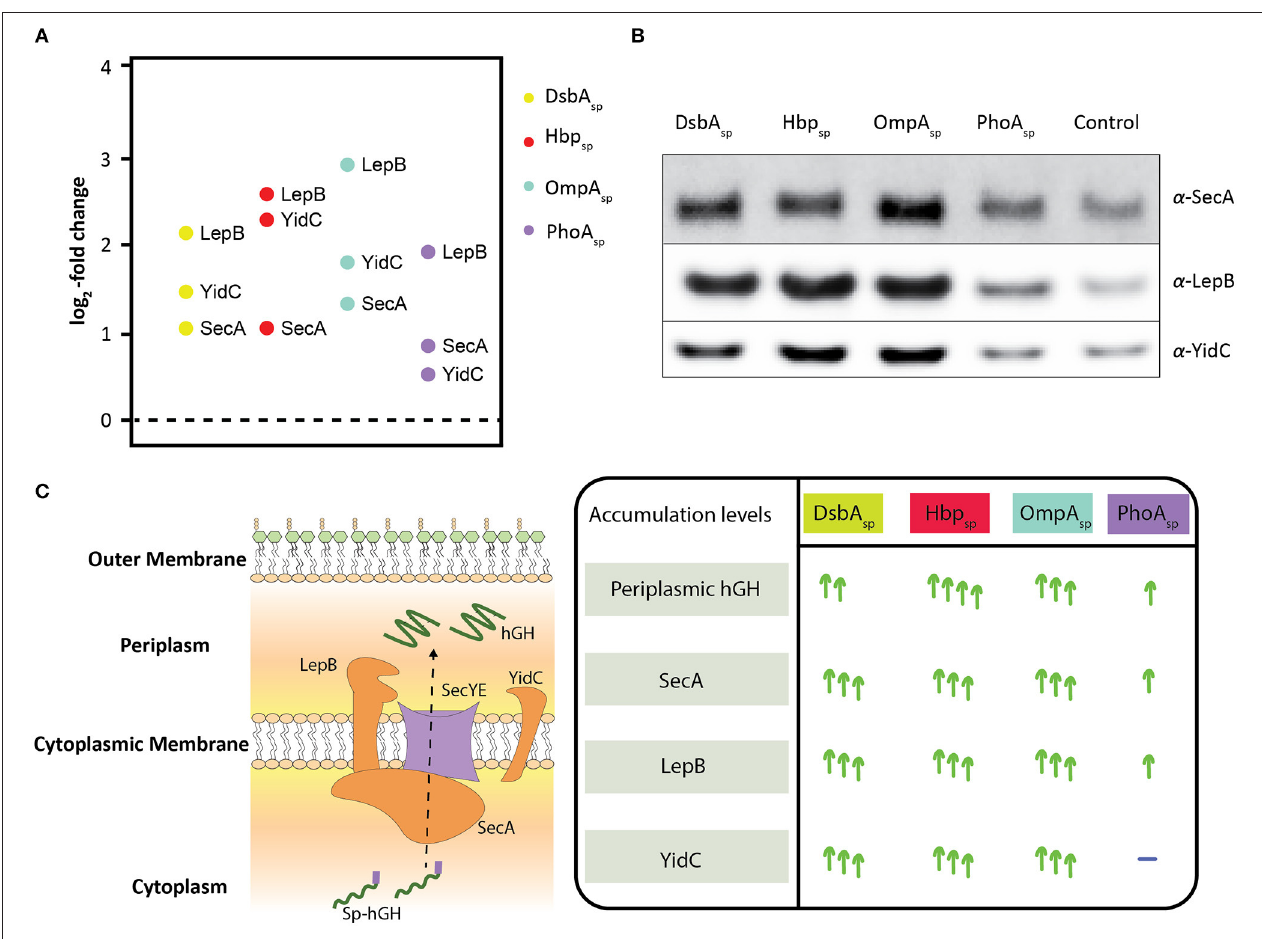
FIGURE 2 | Effects of enhancing periplasmic hGH production using DsbA sp , Hbp sp , OmpA sp , and PhoA sp on the accumulation levels of SecA, Lep, and YidC. (A) Three key components involved in protein translocation, SecA, LepB, and YidC, were identified showing statistically significant